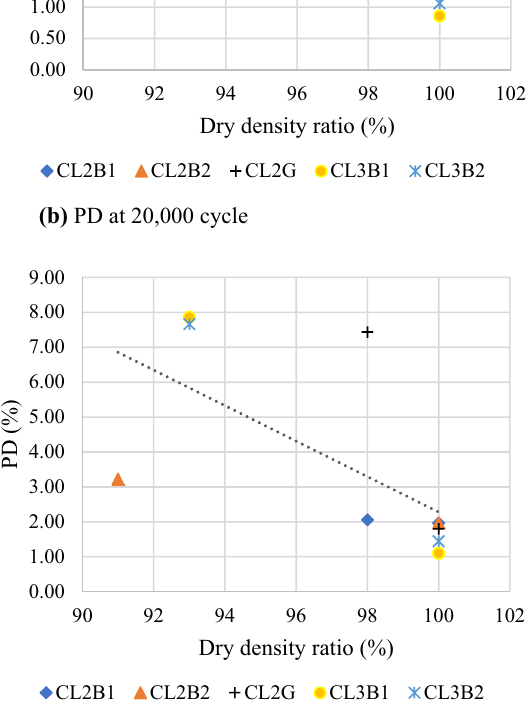
Fig. 7 Effect of dry density on PD of